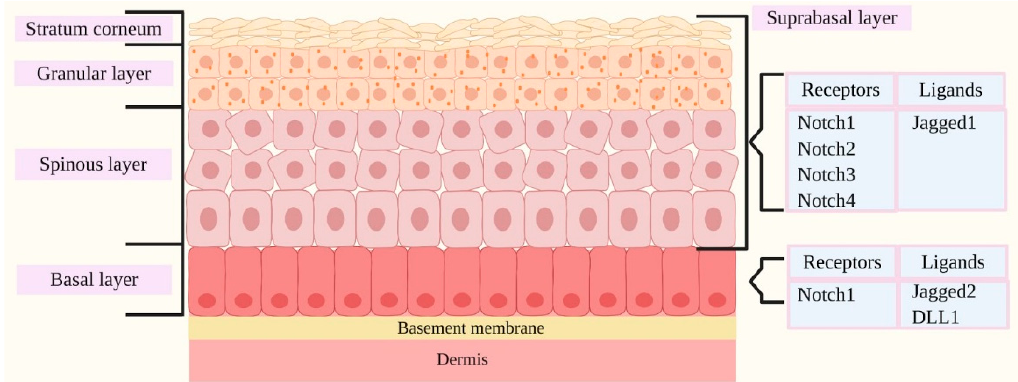
Figure 4. Distribution of Notch ligands and receptors in human skin. Notch1–4 receptors and their ligands are involved in the maintenance of epidermal homeostasis principally by regulating proliferation and differentiation programs within the epidermal cells, mediating the balance between proliferating basal progenitors and the terminally derived differentiated progeny, ultimately leading to the formation of the epidermal barrier. The distinctive expression patterns of Notch receptors and their ligands within the different epidermal layers seem to be associated with the activation of layer-specific target genes. Notch1–4 receptors have been reported to be expressed in the suprabasal layers, while Notch1 receptor seems to be widely expressed in the basal layer. Jagged1, Jagged2 and Delta-like 1 (DLL1) are the Notch ligands detected in the epidermis. The expression of Jagged1 has been reported to be predominant in the suprabasal layer, while Jagged2 and DLL1 have been primarily identified in the basal layer.